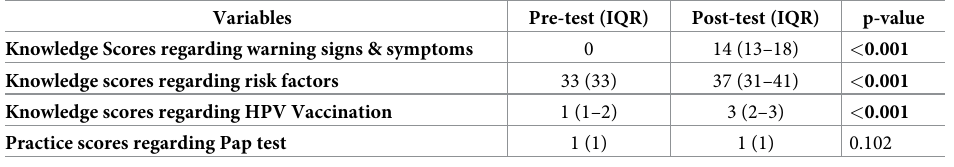
Table 3. Comparison of knowledge median scores regarding warning signs & symptoms, risk factors, and HPV vaccination and practice scores of Pap test before and after the intervention (n = 102). Variables Pre-test (IQR) Post-test (IQR)